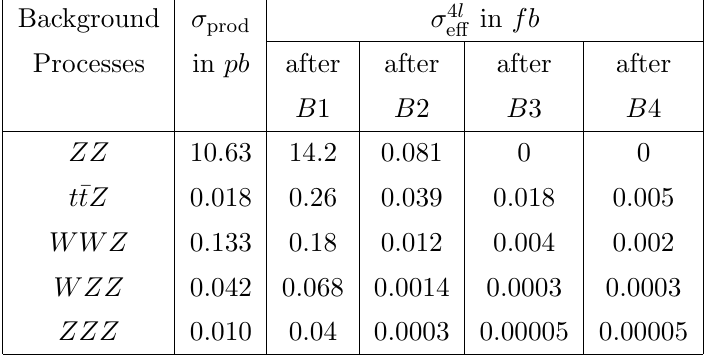
Table 11 . The production and e(cid:11)ective cross-sections ( (cid:27) 4 l